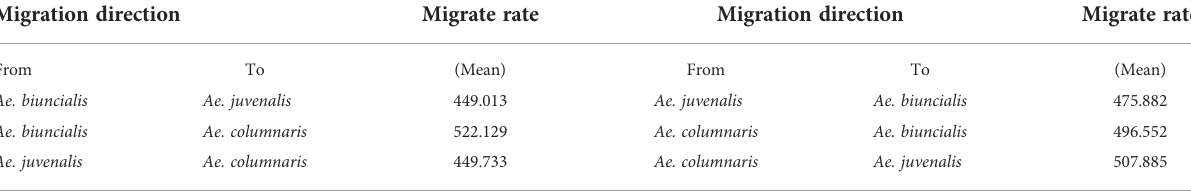
Migration direction Migrate rate